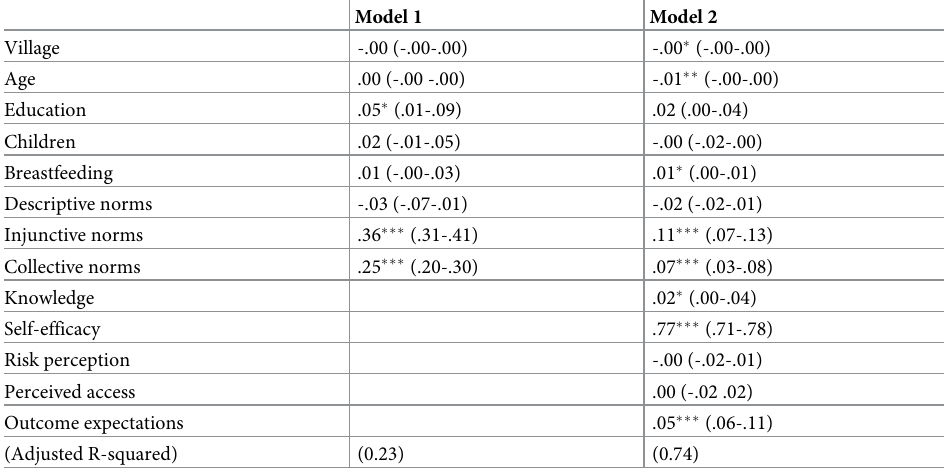
Table 3. Associations with intentions to take iron folic acid supplements among non-pregnant women ages 15–49 in Angul, Odisha, India, from linear regression equations & 95% confidence intervals (N =